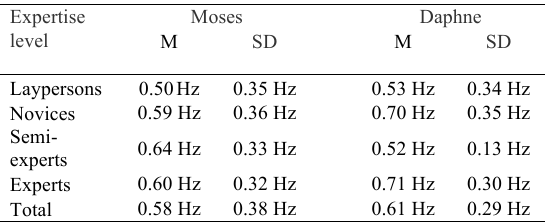
Table 4. Mean values and standard deviations of the frequency of switching between global and local viewing per second, by expertise level and sculpture.